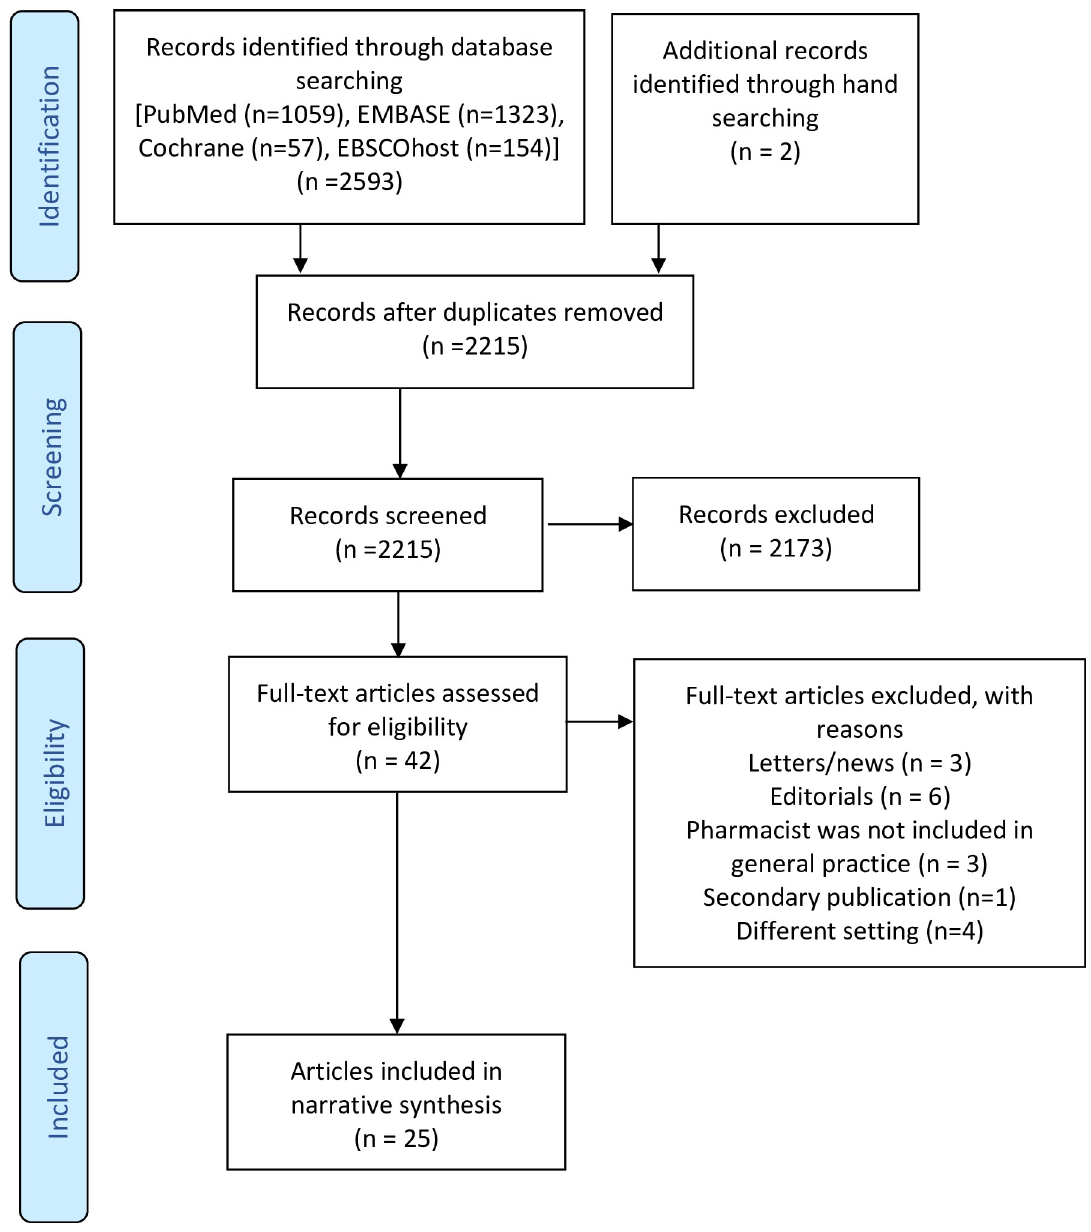
Fig 1. Flowchart depicting